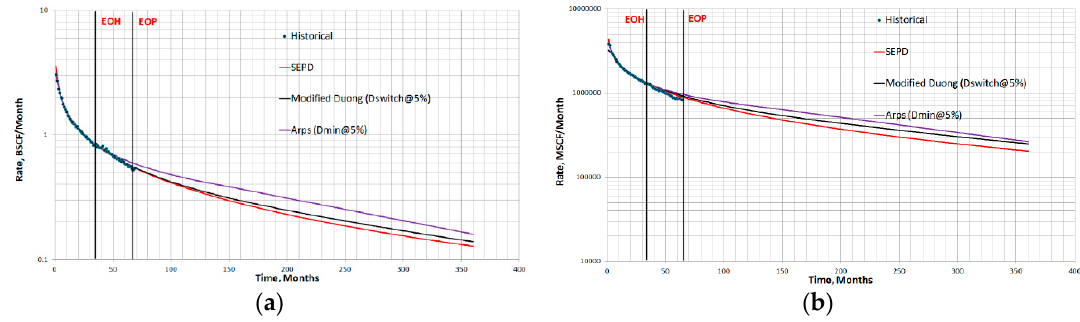
Figure 5. Comparison results for two well groups from Barnett shale [13], where EOH stands for the end of history used in the matching, and EOP is the end of production data. In both cases 36 months of historical data were used for matching. ( a ) Comparison results for an 81-well Denton County group; ( b ) comparison results for a 127-well Wise County group.